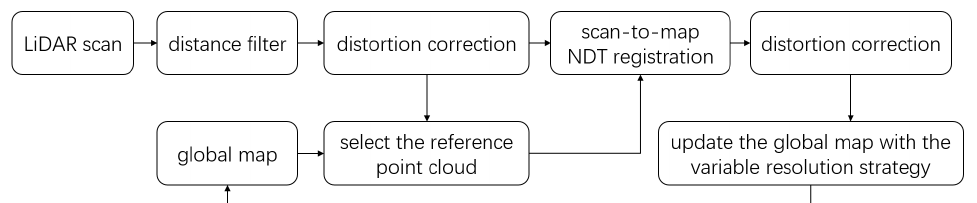
Figure 1. The pipeline of the 3D LiDAR mapping